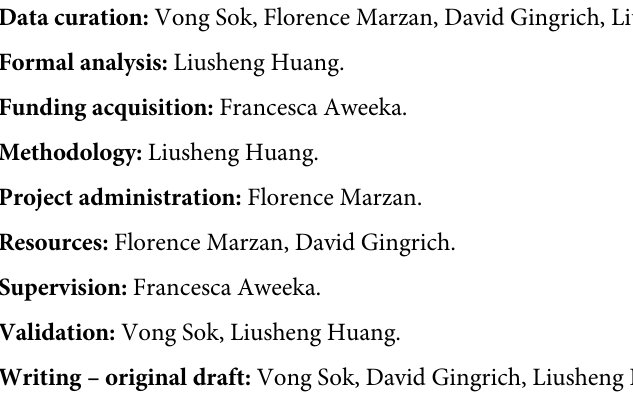
S2 Fig. LLOQ versus ULOQ chromatograms. S1 Table. Adsorption of internal standards on container surface. S2 Table. Stability